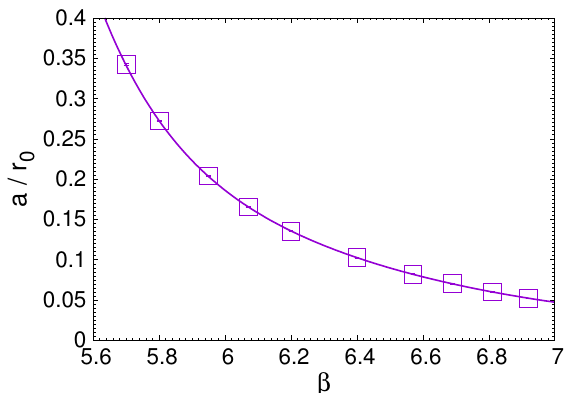
Figure 6 . The (cid:12) dependence of the Sommer scale a=r 0